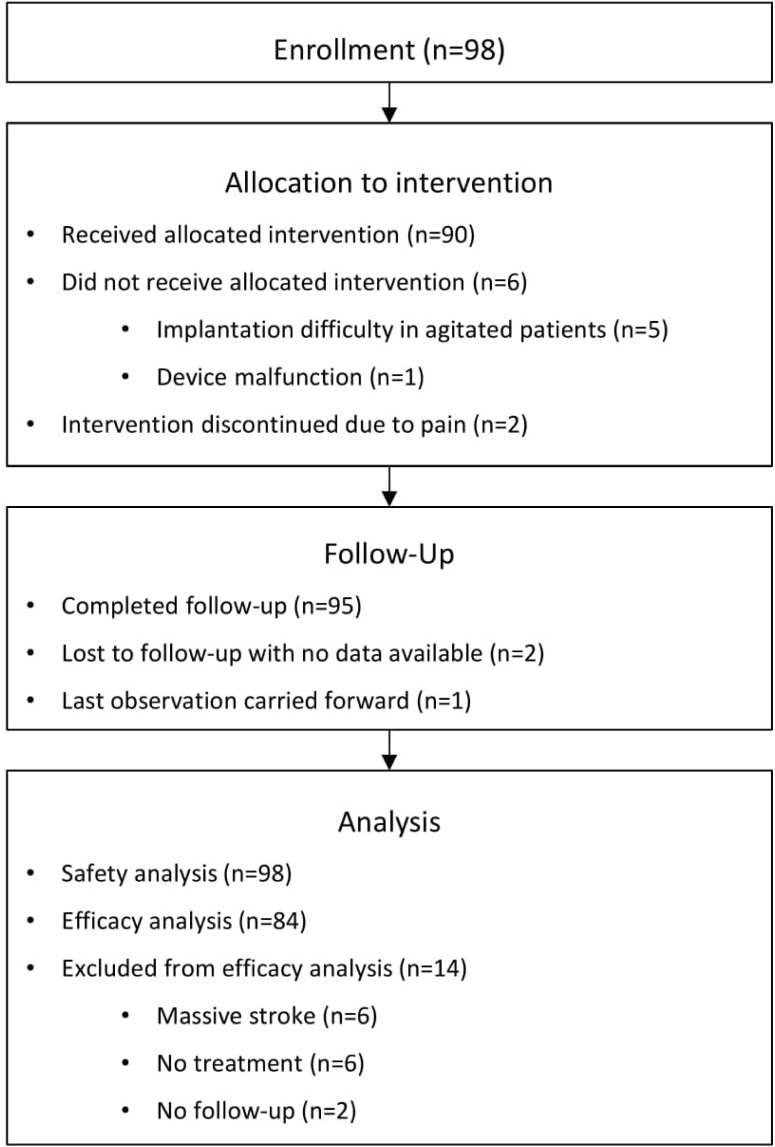
CONSORT flowchart.